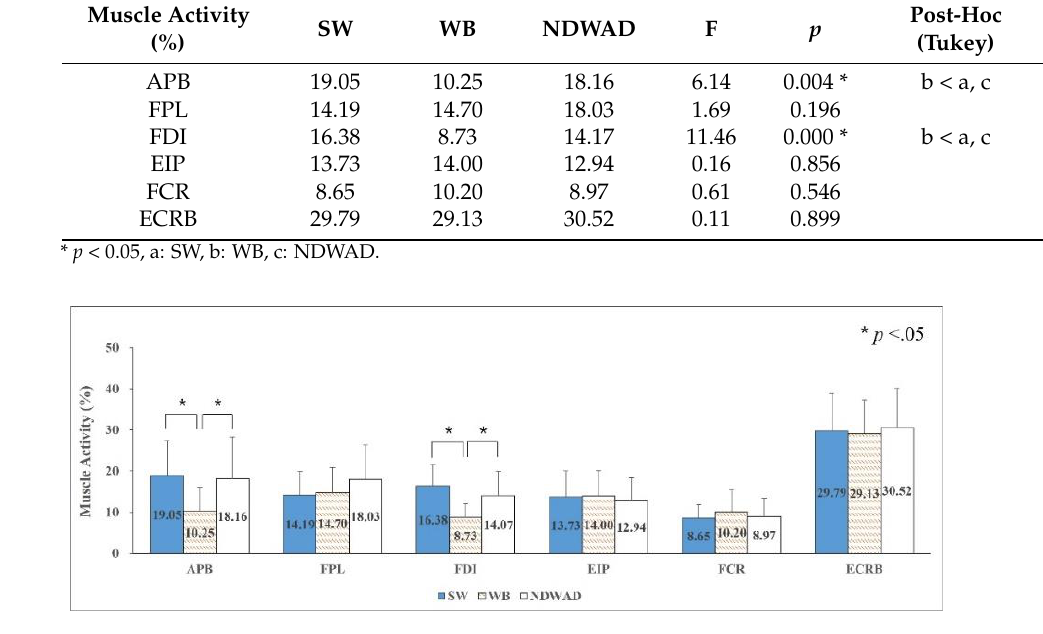
Figure 5. Mean muscle activity of the hand and wrist.